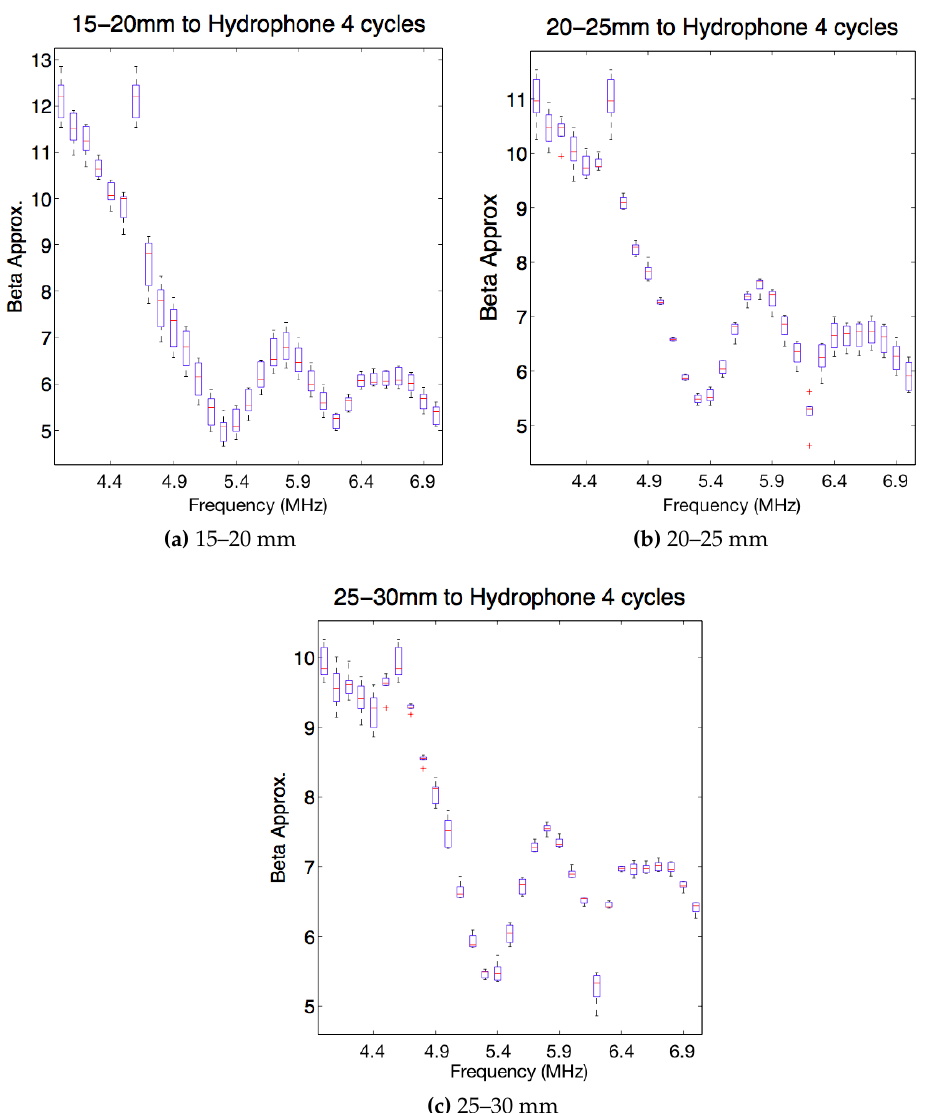
Figure 13. Box-plot beta versus frequencies from 4 MHz to 7 MHz in steps of 0.1 MHz for 4 cycles. Mean and standard deviation values are computed considering different distances specimen-hydrophone: in ( a ) distance 15–20 mm, in ( b ) distance 20–25 mm and in ( c ) distance 25–30 mm. With the last box-plot it can be deduced the appropriate distance to do a feasible measurement. This could be fitted in the range of 25–30 mm because in this range, for the number of cycles fixed previously (4 cycles), there are not interferences and the value of beta has lower dispersion than with other distances. Within this range, for a shorter distance the attenuation is lower than in a longer distance. Therefore it is desirable to choose a distance near to 25